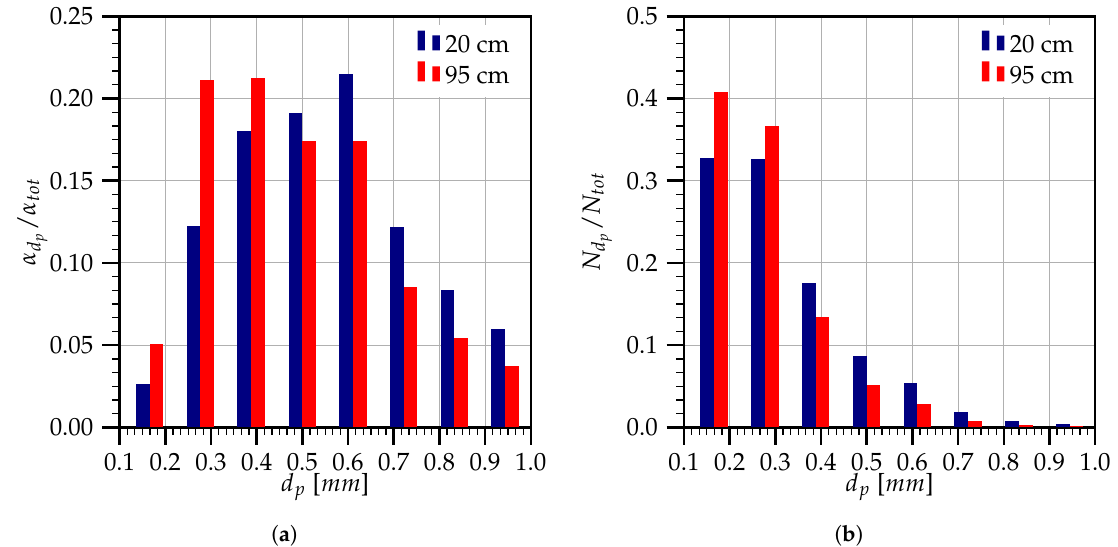
Figure 12. Histogram for different droplet diameters at vertical distances from the nozzle h = 20 cm and h = 95 cm; ( a ) normalized volume fraction α d / α tot and ( b ) normalized number fraction N d p